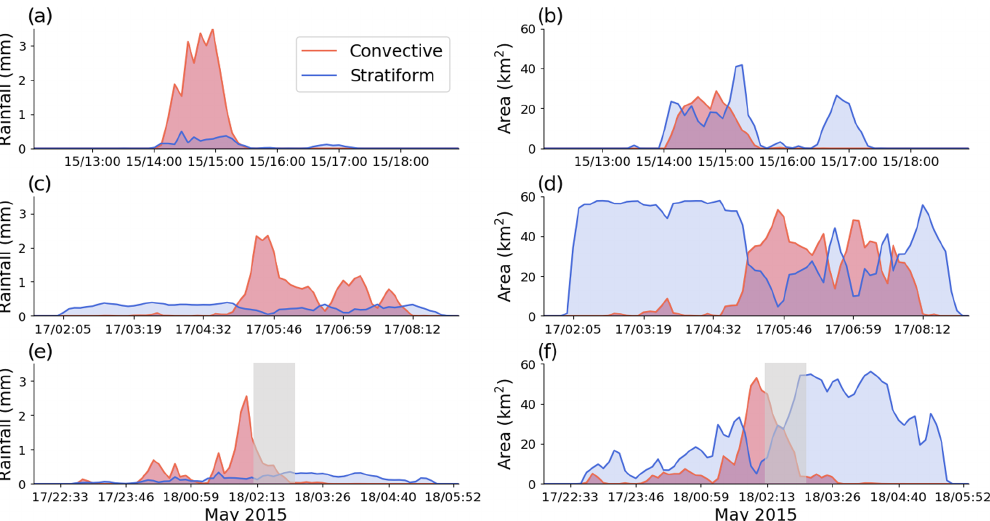
Figure 11. The 5min time series of convective and stratiform rainfall over the La Liboriana basin during the period of maximum accumulation of each of the three events in Fig. 10, as well as the evolution of the area of the basin covered by either stratiform or convective precipitation. (a, b) correspond to the 14–15 May event, (c, d) to the 17 May event, and (e, f) to the 17–18 May triggering event. The gray shadow in (e, f) corresponds to the approximate timing of the flash flood event in different parts of the basin according to local authorities and the community (from 02:10 to